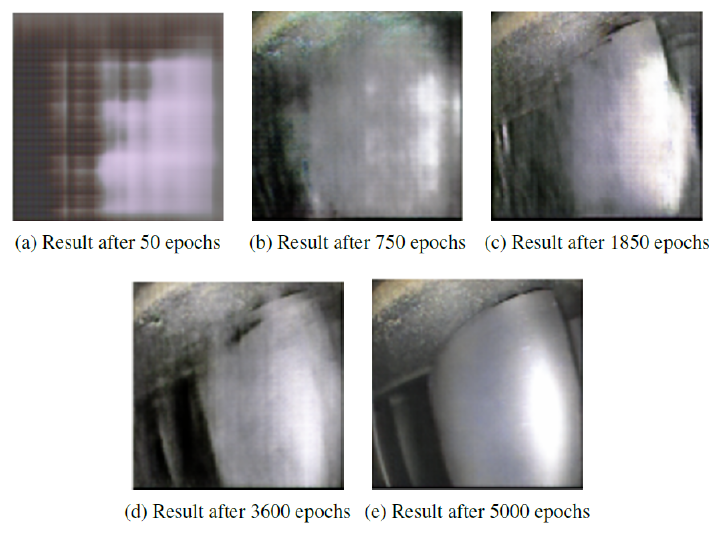
Figure 3. Synthetic image generation using DCGAN in 5000 epochs.